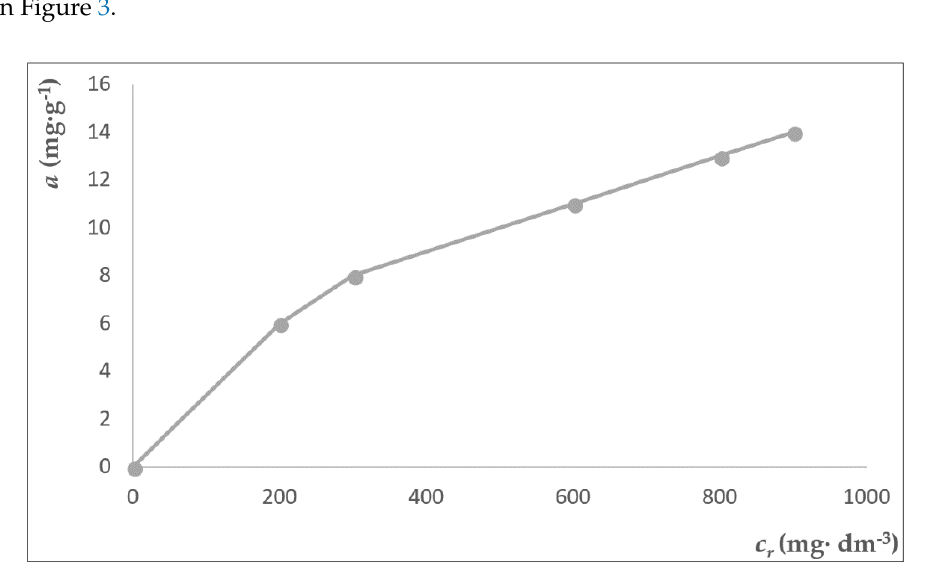
Table 7. Obtained experimental parameters.